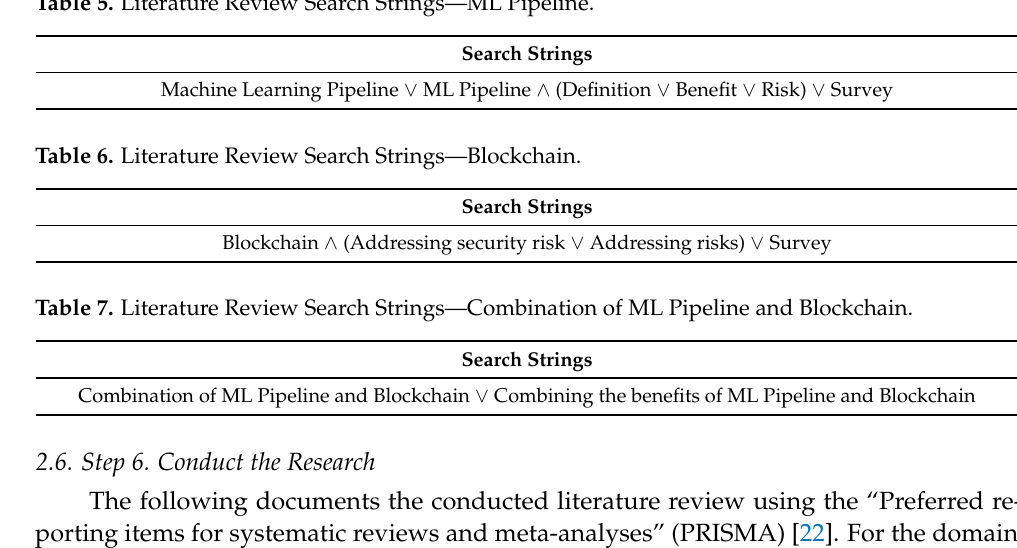
Table 5. Literature Review Search Strings—ML Pipeline.